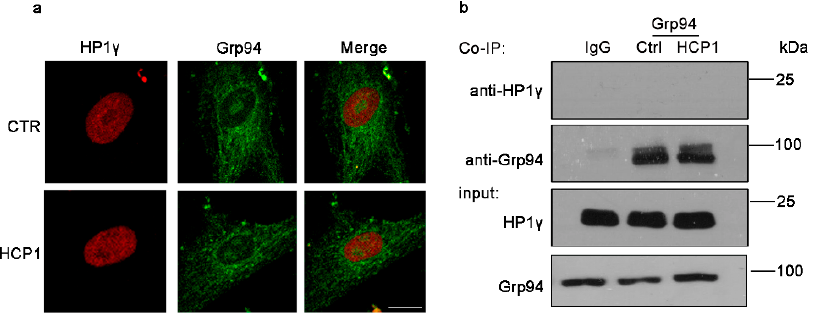
Figure 4. Interaction of HP1 γ and Grp94. After senescent HDFs (PDL > 30) were treated with 0.5 µ M HCP1 for 48 h, Immunofluorescence ( a ) and Co-IP ( b ) were performed to detect the interaction of HP1 γ and Grp94. Scale bar: 20 μ m.